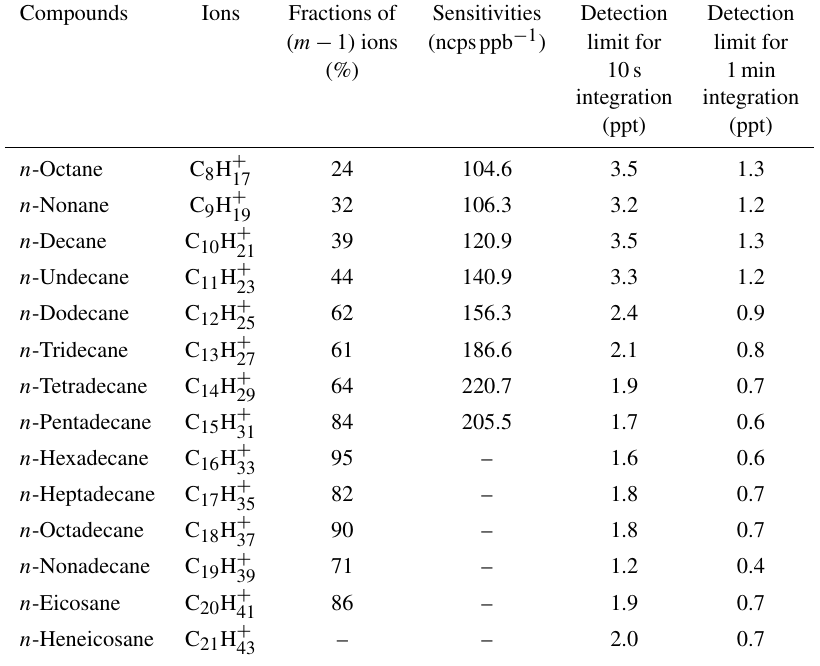
Table 1. Fractions of product ions ( m − 1) in mass spectra, and sensitivities and detection limits of higher alkanes in NO + PTR-ToF-MS. Compounds Ions Fractions of Sensitivities Detection Detection limit for limit for integration